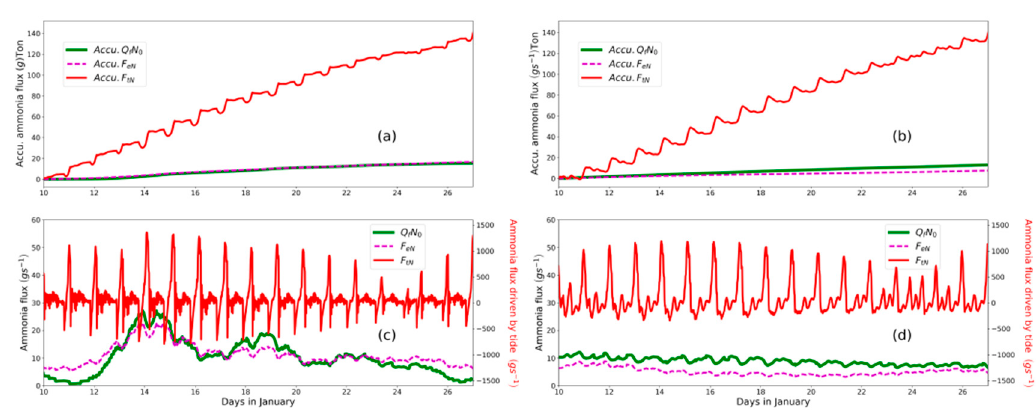
Figure 7. Ammonia flux resulting from tidal oscillation (red line), subtidal estuarine circulation (magenta dash line), net outflow (green line) in the tide-receiving scenario ( d ) and the non-tide-receiving scenario( c ). Accumulative flux since the 10 January for the non-tide-receiving scenario is plotted in ( a ) and tide-receiving scenario in ( b ). A positive value indicates an oceanward flux.